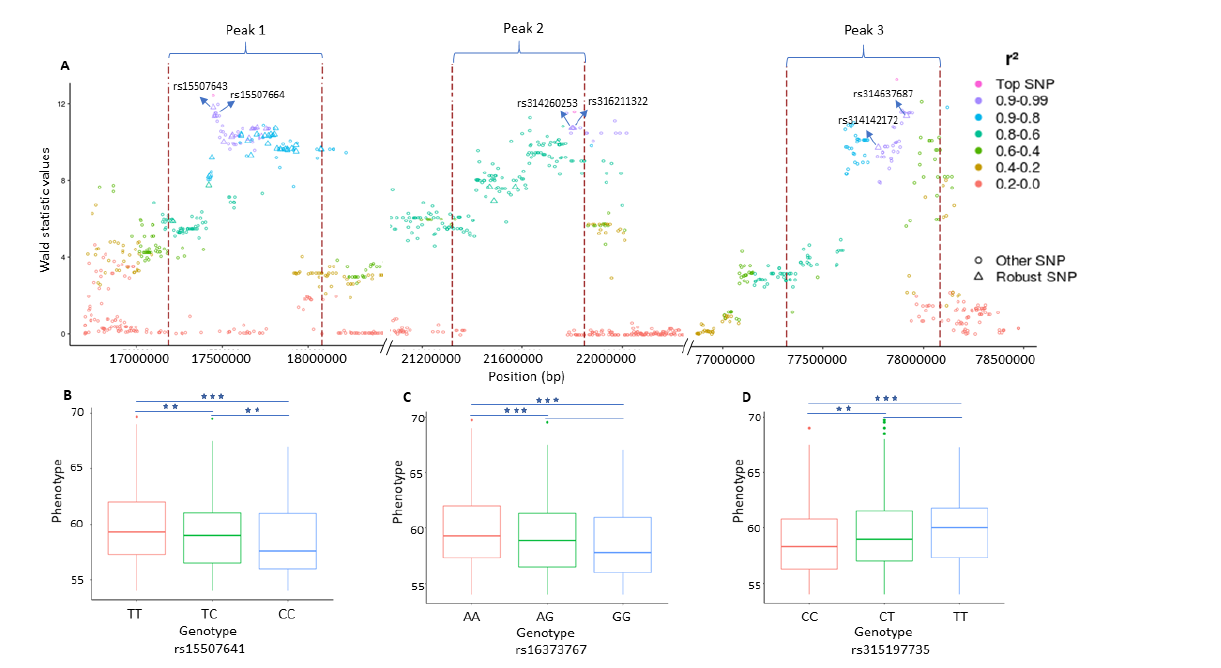
Figure 4. Plot representing three genomic regions on chromosome 4 in association with egg weight (EW). ( A ) Plot representing the LD structure inside and around the significant peaks. The dotted red lines depict the boundaries of the peaks. Each point represents a SNP and the color shows the strength of linkage disequilibrium (LD) between the top single nucleotide polymorphisms (SNPs) inside each peak and the surrounding SNPs. The diamond shape points inside the peak depict the robust SNPs. The X-axis contains the SNP positions on the chromosome while the y-axis depicts the Wald statistic values obtained from single-SNP based GWAS analysis. (( B – D ) The effects of different genotypes of the three leading SNPs identified for EW and their significance ( ∗∗ p < 0.01, ∗∗∗ p < 0.001 )